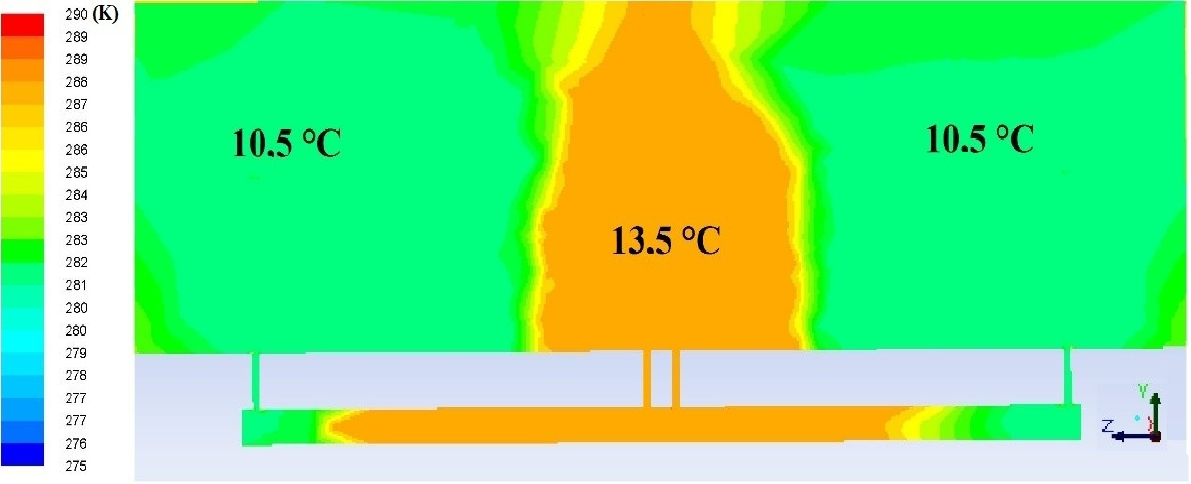
Figure 11. Air temperature distribution (in K) in the greenhouse and the rock bed blocks during the destocking phase at midnight (273 K = 0 °C).